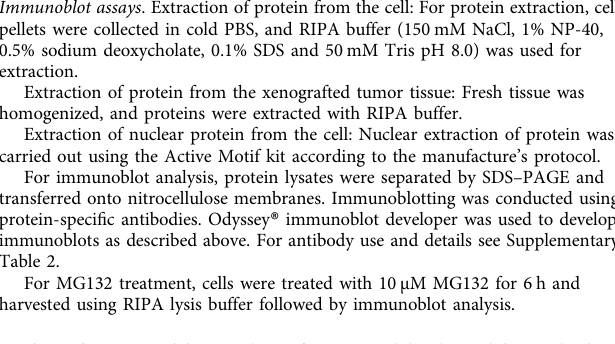
Table 2. For MG132 treatment, cells were treated with 10 µM MG132 for 6 h and harvested using RIPA lysis buffer followed by immunoblot analysis. Analysis of protein stability . Analysis of protein stability by cycloheximide chase assay was performed using standard procedures as described previously 58 . Brie fl y, 22Rv1sgCtrl and 22Rv1sgG3BP1, C4-2B non-targeted and C4-2B SPOP KO cells were incubated with 100 µM of cycloheximide for various times as indicated in